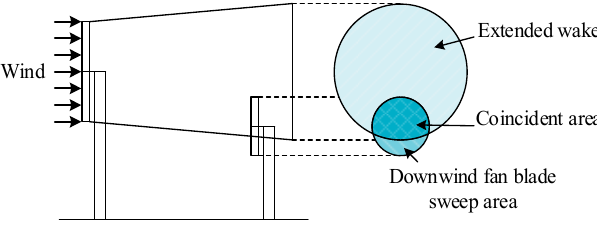
Figure 1. The control mode of the WT.